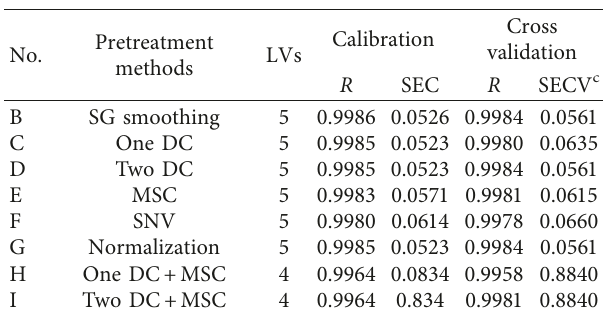
Figure 4: Enlarged view of the shifts in the NIR spectrum baseline (a). Correlogram of the NIR spectra and Tween-80 concentration (b). Relational graph of LV numbers and SECV of Tween-80 (c). Table 1: Comparison of different calibration models of Tween-80 content developed with different spectral preprocessing